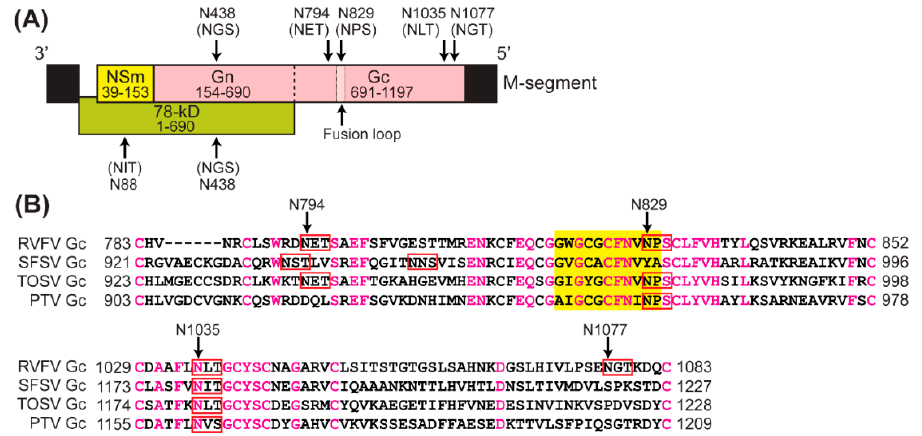
Figure 1. The asparagine (N)-any amino acid (X)-serine (S)/threonine (T) sequons of Rift Valley fever virus (RVFV) and other related phleboviruses. ( A ) Schematic diagram of the M-segment RNA and protein expressions. The RVFV medium (M)-segment encodes a single M mRNA, and co-translational cleavage and leaky ribosomal scanning of the initiation codons produce at least four proteins: 78-kD, nonstructural protein m (NSm) and glycoproteins Gn, and Gc. The Gn, and Gc are structural proteins, and the 78-kD protein is structural when virions are made in mosquito cells. There are six N-X-S/T sequons, which are potentially utilized for N -glycosylation: N88 (78-kD), N438 (Gn and 78-kD), N794 (Gc), N829 (Gc), N1035 (Gc), and N1077 (Gc); ( B ) Partial alignment of Gc amino acid sequences among RVFV, Sandfly fever Sicilian virus (SFSV: Genbank Accession No. U30500), Toscana virus (TOSV: Genbank Accession No. X89628), and Punta Toro virus (PTV: Genbank Accession No. DQ363407). Conserved amino acids are shown in pink, while the N-X-S/T sequons are shown in red squares. Positions of amino acids (aa.) at the amino (N)- and carboxyl (C)-termini of sequences are also shown. The fusion loop at aa. 820 to 830 is shown in